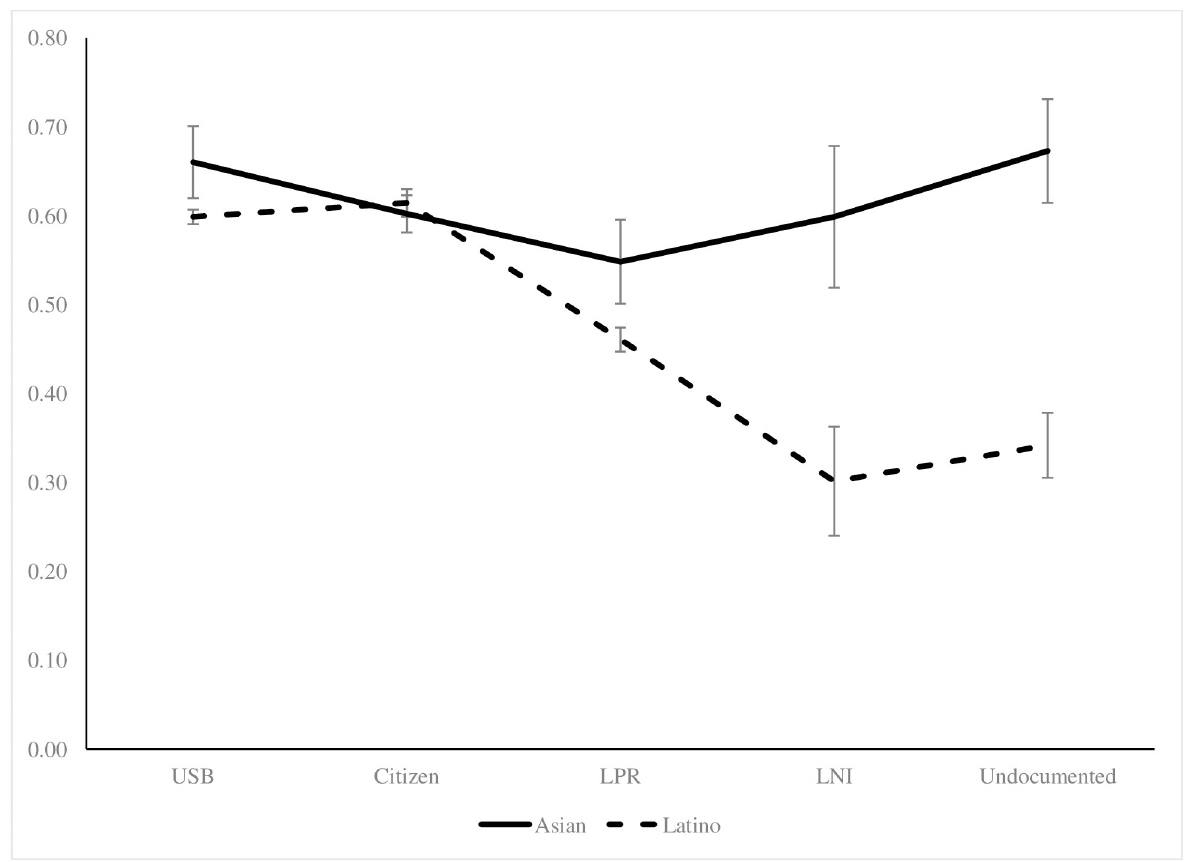
Fig 3. Predicted probabilities of current health insurance by immigration status, Latinos and Asians, 2001/2004/2008 SIPP.